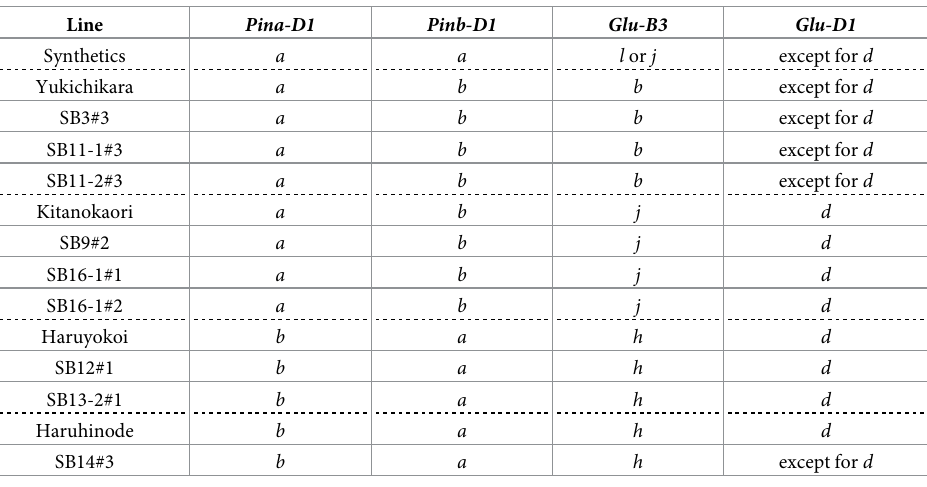
important loci for determining wheat grain quality [52,53]. Most of the selected early heading lines provided the same allele combination for the four grain character-related loci as the parental wheat cultivars, but not so for the parental synthetic wheat lines (Table 4). In the two Vrn-1 loci, Vrn-B1 and Vrn-D1 , and three Ppd-1 homoeologous loci out of the seven heading time-related genes, the selected lines possessed almost the same allele combinations as the parental cultivars (Table 5). Yukichikara and SB3#3 produced no amplified fragment for Vrn- B1 with the primer sets used in this study. This means that they have novel Vrn-B1 alleles. The Vrn-A1 allele of Horuyokoi- and Haruhinode-derived lines corresponded to that of the paren- tal cultivars, whereas the Vrn-A1 allele was derived from Ldn in the Yukichikara- and Kitano- kaori-derived lines. Table 5. PCR-based genotyping of the Vrn-1 and Ppd-1 alleles in the selected early flowering lines and their four parental cultivars. Line Synthetics